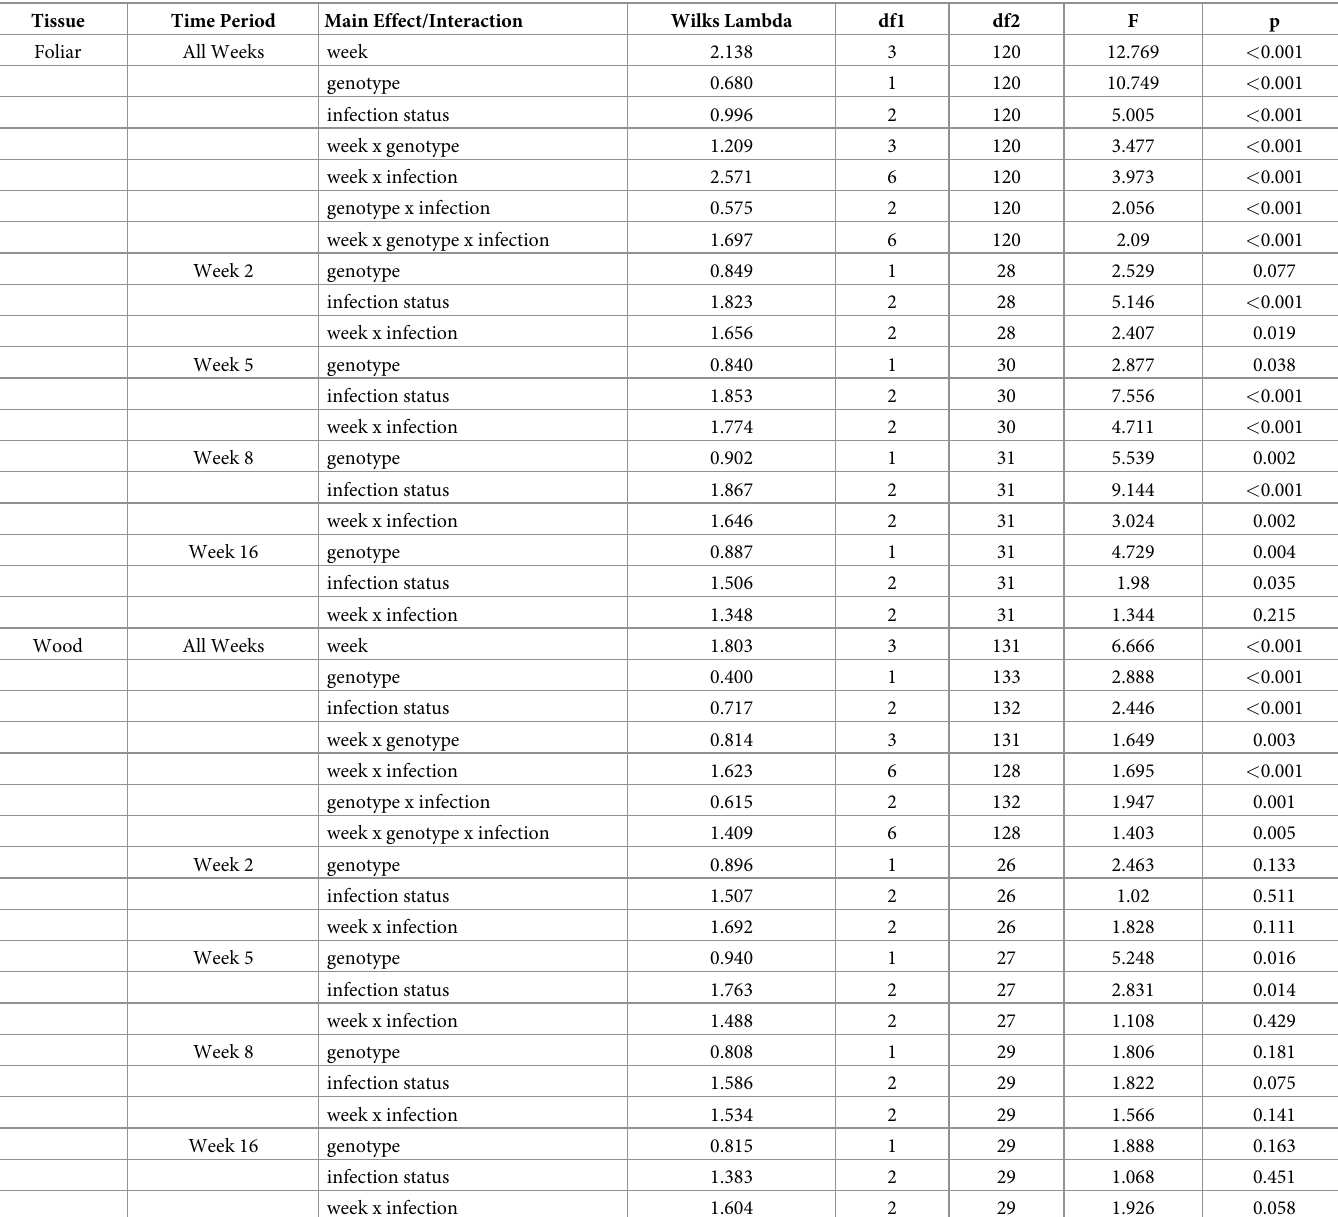
Table 2. MANOVA statistics for analyses including all individual foliar or woody tissue compounds. Tissue Time Period